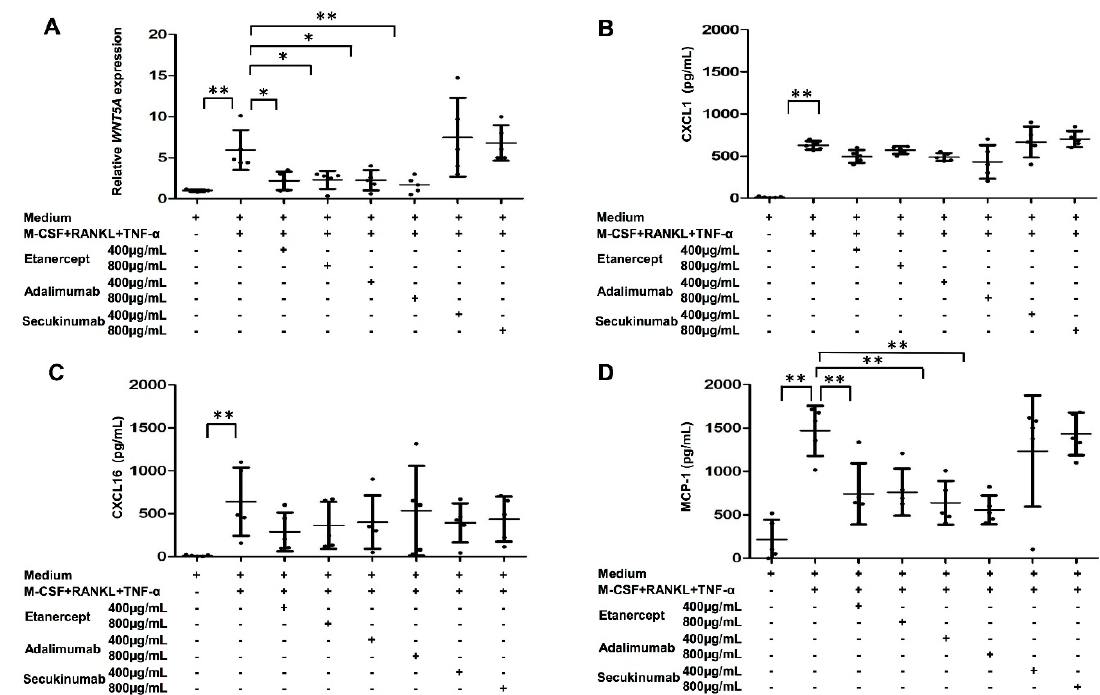
Figure 6. Anti-TNF- α agents inhibit the production of WNT5A and MCP-1 in MDOC from PsA patients. MDOC were obtained from 5 PsA patients as described previously. MDOC were treated with anti-TNF- α (adalimumab at 400 and 800 µ g/mL or etanercept at 400 and 800 µ g/mL) and anti- IL-17A (secukinumab at 400 and 800 µ g/mL) agents on Days 3 and 9. On Day 13, the supernatants and RNA samples from MDOC were collected. ( A ) The expression level of WNT5A in MDOC was measured using qRT-PCR. The levels of CXCL1 ( B ), CXCL16 ( C ), and MCP-1 ( D ) in the supernatants were measured via ELISA. The error bar is the standard deviation of each data set. * indicates p < 0.05, and ** indicates p < 0.01.